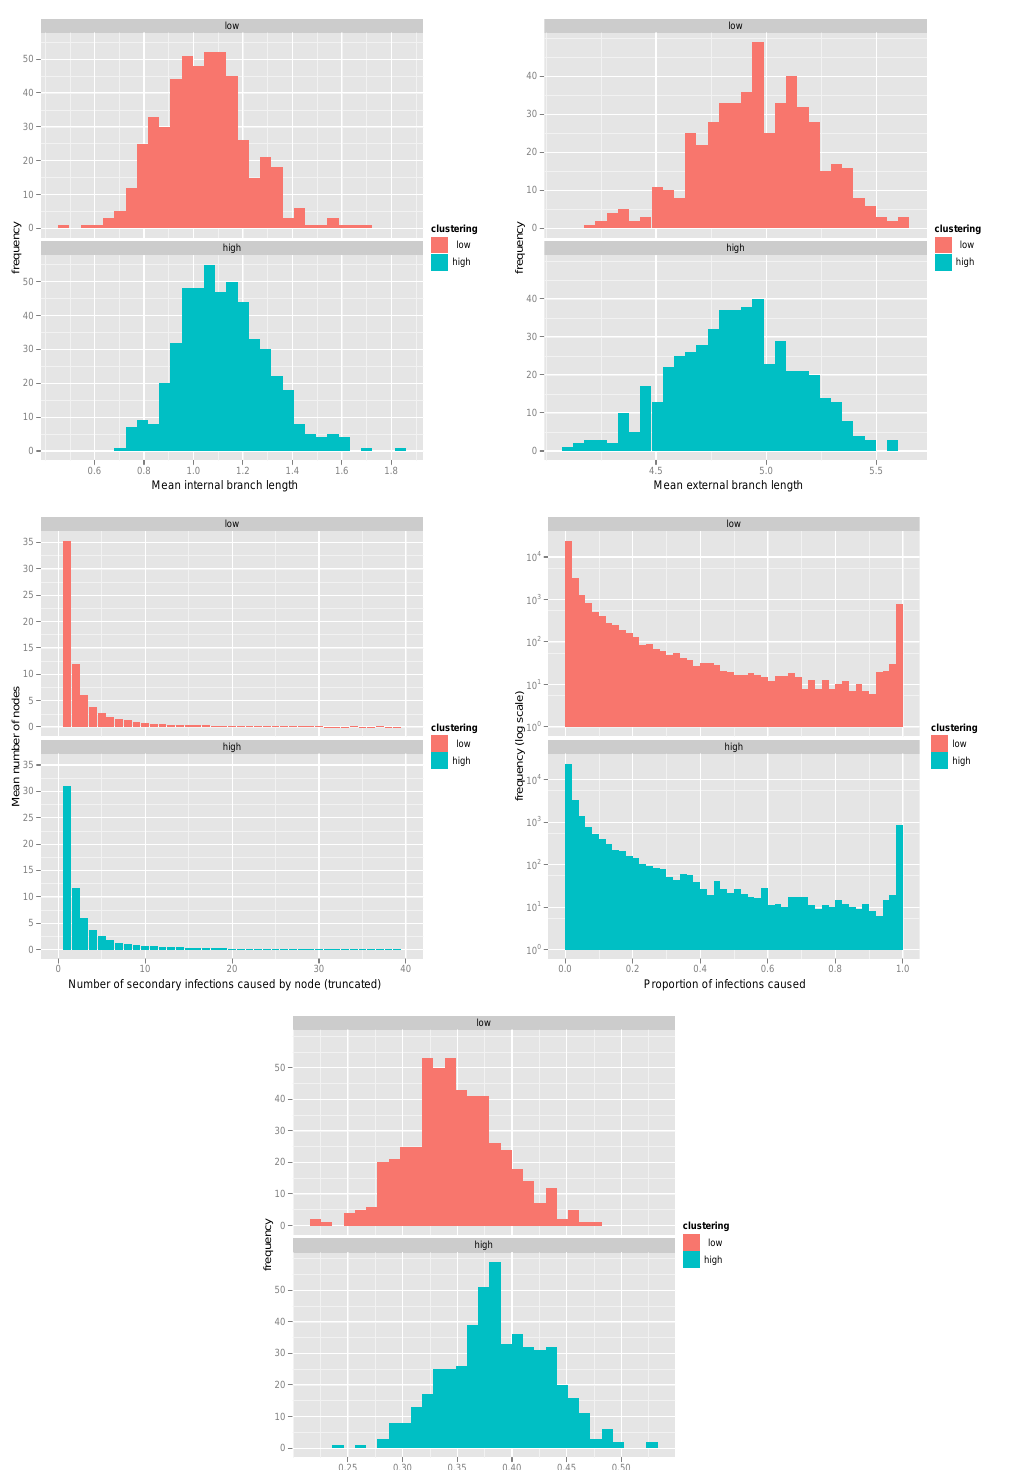
Figure 7. Empirical distributions of summary statistics of transmission trees from epidemics on power-law networks. (top left) Mean internal branch length; (top right) Mean external branch length; (middle left) Number of secondary infections by node; (middle right) Number of total infections by node, vertical axis on log-scale; and, (bottom) Number of cherries in tree as a proportion of possible